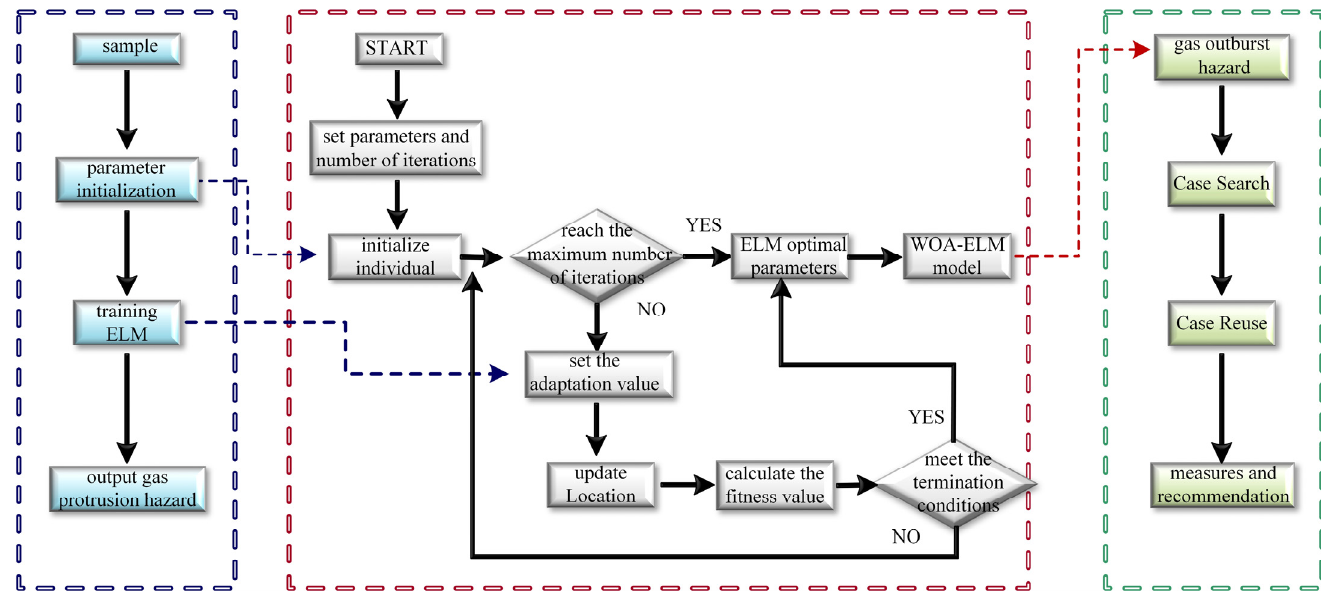
Figure 1. Flow chart of gas outburst prediction and management.